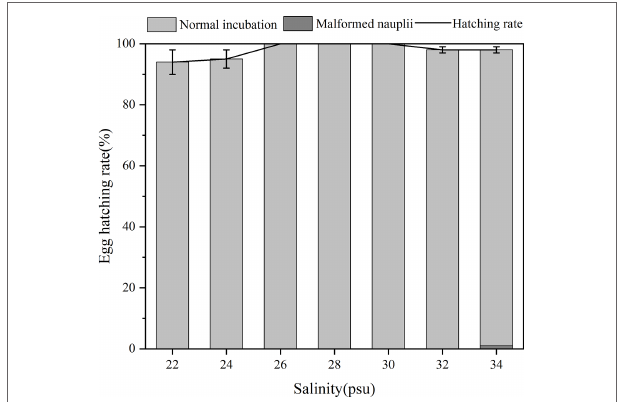
FIGURE 6 | Egg hatching rate of B. amoyensis incubated at seven different salinities (N=45). Data are presented as mean± standard error